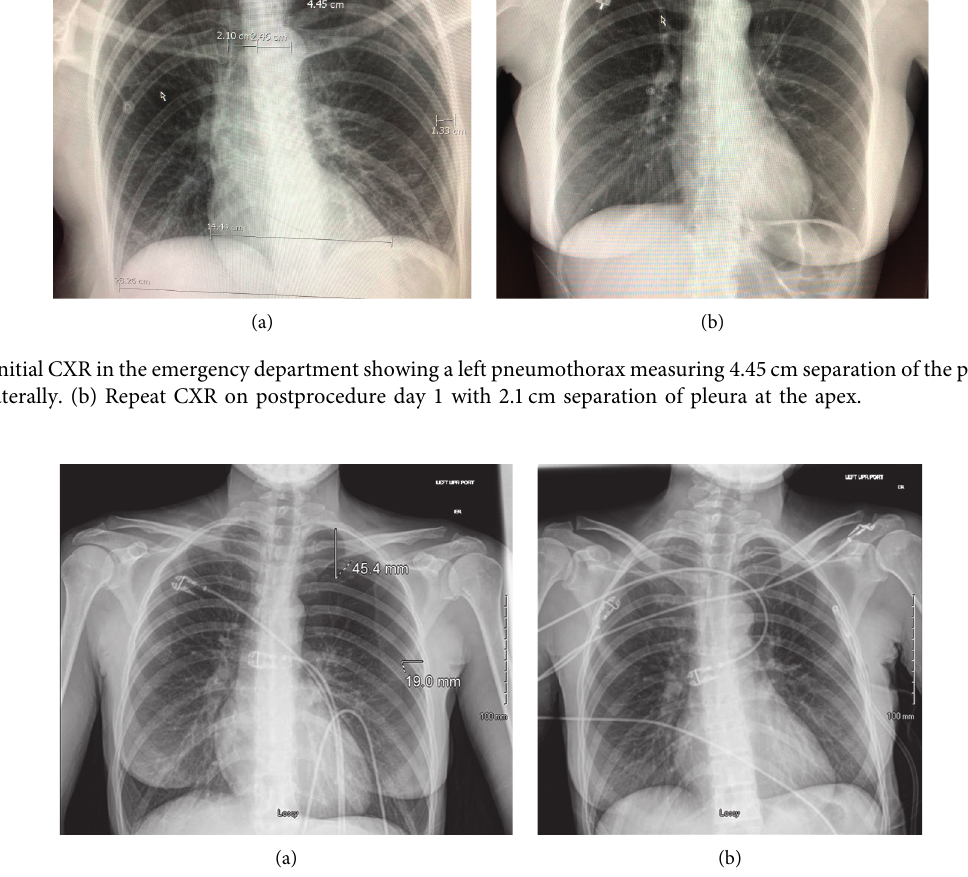
Figure 2: (a) Initial AP CXR showing medium left PTX measuring 4.54 cm separation of the pleura at the apex and 1.90 cm laterally. (b) Repeat AP CXR after chest tube placement with reexpansion of the left